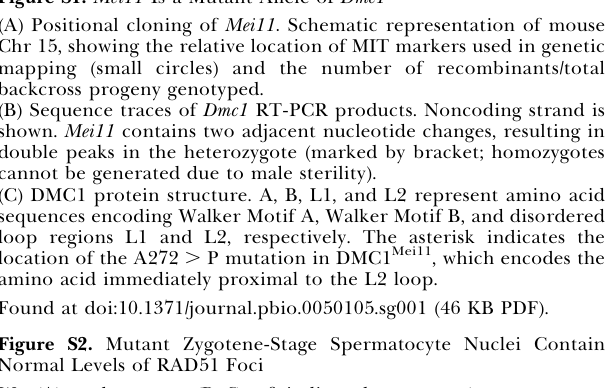
Figure S5. Synaptic Defects, Core Fragmentation, and Persistent DSBs in Mutant Oocytes with . 40 Meiotic Cores Genotype abbreviations are as in Figure S4. (A–B) Mutant oocytes with . 40 meiotic cores showing a lack of synapsis. (C) Wt oocyte nucleus with fully synapsed chromosomes. (D) Core fragmentation in mutant as suggested by lack of CREST staining (white arrow denotes fragmented core lacking centromeric CREST staining). (E) Persistent DSBs as identified by persistent RAD51 foci. Found at doi:10.1371/journal.pbio.0050105.sg005 (140 KB PDF). Figure S6. The Mei11 Mutant Allele Does Not Disrupt DMC1 Homotypic Protein Interactions Shown are yeast two-hybrid interactions of mouse wt and DMC1 Mei11 proteins, with clones and yeast strains constructed as described in Materials and Methods. All strains were grown on SD-Leu/Trp/His/ Ade agar plates. 1–2: DMC1 bait/DMC1 Mei11 prey; 3–4: DMC1 bait/ DMC1prey; 5–6: DMC1 Mei11 bait/DMC1 Mei11 prey. Found at doi:10.1371/journal.pbio.0050105.sg006 (37 KB PDF). Figure S7. DMC1 Mei11 Does Not Affect the Ability of DMC1 to Form D-Loops (A) The ability of human DMC1 (HuDMC1) to form D-loops was analyzed in the presence of varying amounts of HuDMC1 Mei11 (A272P). HuDMC1 and A272P were incubated together in the indicated ratios (1 mM total protein concentration) with ssDNA, followed by the addition of dsDNA. For mock treatments, an identical volume of A272P-free buffer was added to the reaction (these contained decreasing amounts of wt HuDMC1, identical to that in the WT:A272P lanes). (B) Graphs of data from experiments of the type shown in (A). These represent an average of four independent experiments. Found at doi:10.1371/journal.pbio.0050105.sg007 (38 KB PDF). Table S1. Fecundity of Dmc1 Mei11 / þ Females and Sterility of Dmc1 Mei11 / Dmc1 (cid:3) Females Found at doi:10.1371/journal.pbio.0050105.st001 (19 KB